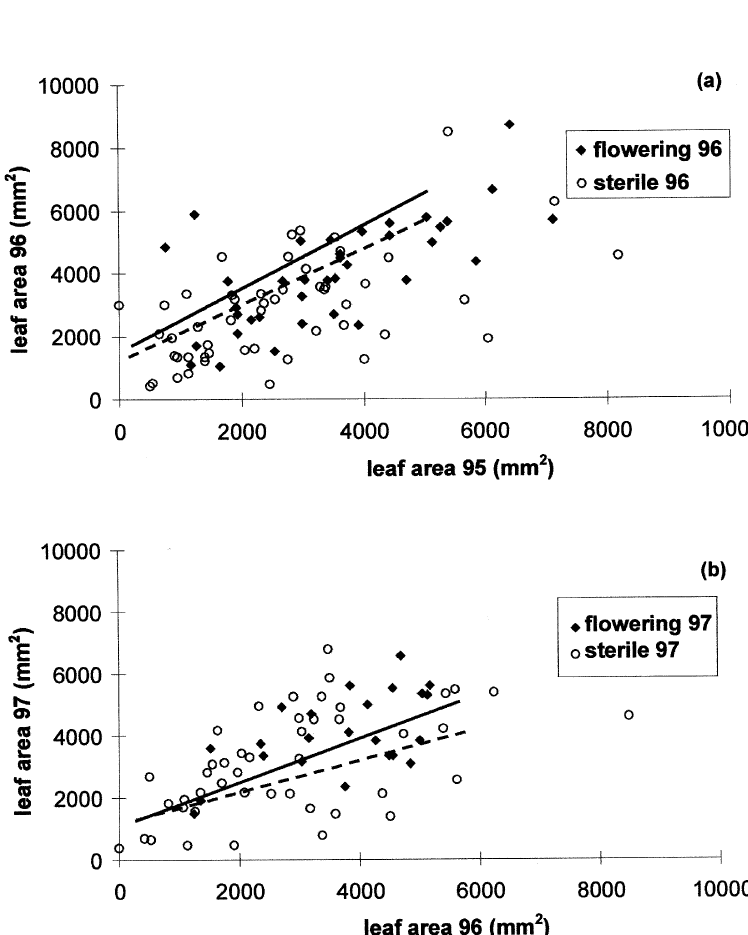
Fig. 2. Correlation between leaf area in mm 2 of Dactylorhiza fuchsii in two consecutive years 1995 vs 1996 (a) and 1996 vs 1997 (b). ◆ : flowering the next year, (cid:1) : sterile the next